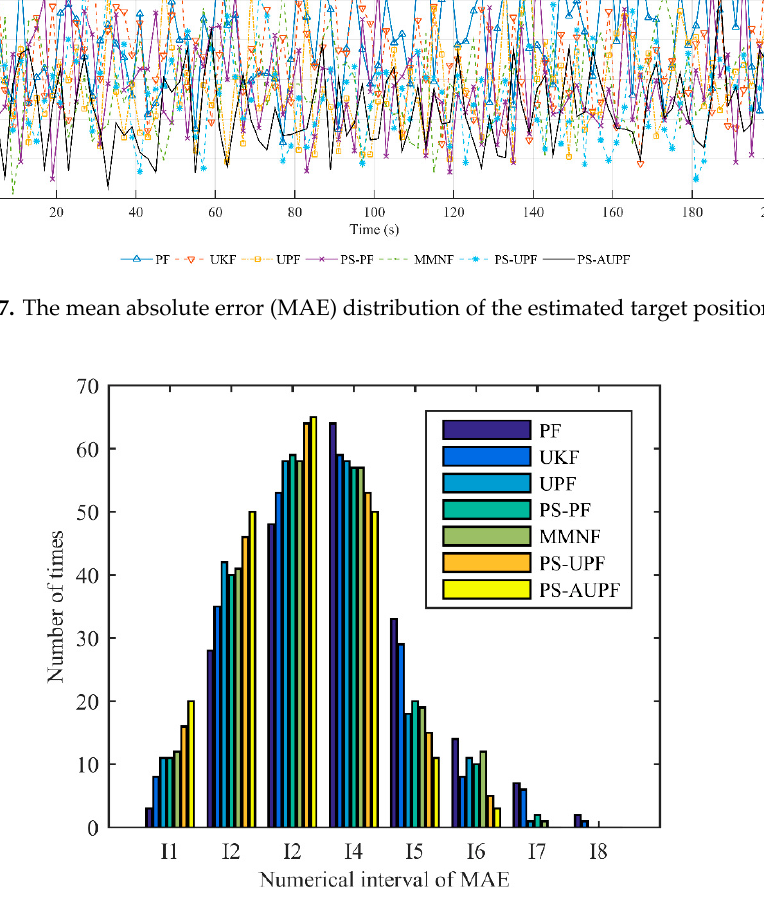
Figure 8. Statistical histogram of tracking MAE distribution for 100 Monte Carlo runs. I1 to I8 represents the numerical interval [0, 50), [50, 100), [100, 150), [150, 200), [200, 250), [250, 300), [300, 350), [350, ∞ ), respectively.